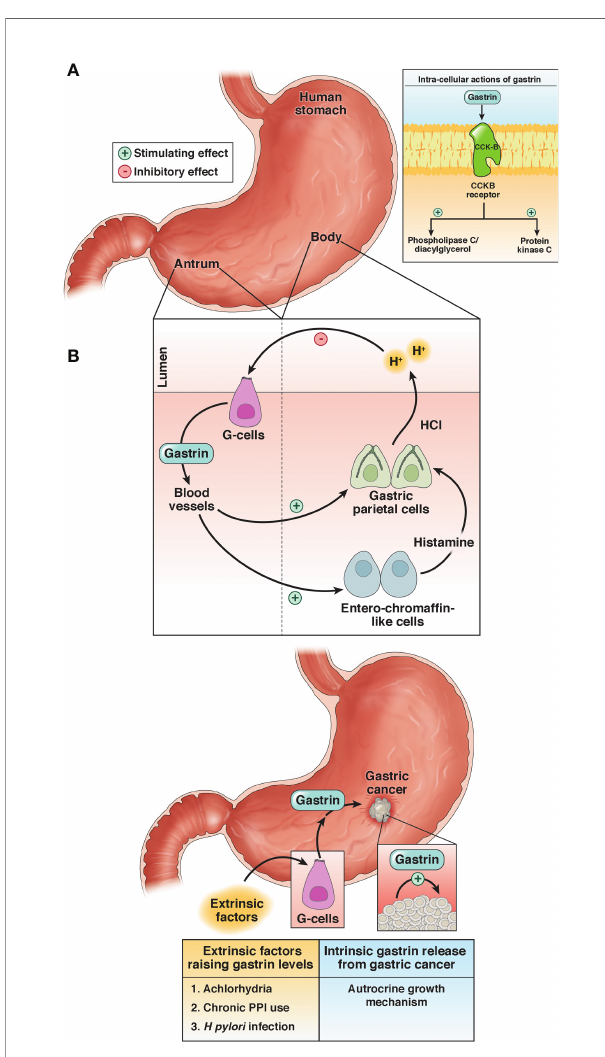
FIGURE 1 | Physiologic and pathologic roles of gastrin. (A) Under physiologic conditions, gastrin is released from the G-cells in the antrum of the stomach and stimulates the release of acid (HCl) by activation of the enterochromaf fi n-like cells and gastric parietal cells. (B) Gastrin stimulates growth of gastric cancer by activating the CCK-BR by an autocrine mechanism or exogenous stimulation by high gastrin blood levels induced by achlorhydria, chronic use of proton pump inhibitors (PPI), or infection with Helicobacter pylori (H. pylori) . Reproduced with permission from the Cell Mol Gastroenterol Hepatol